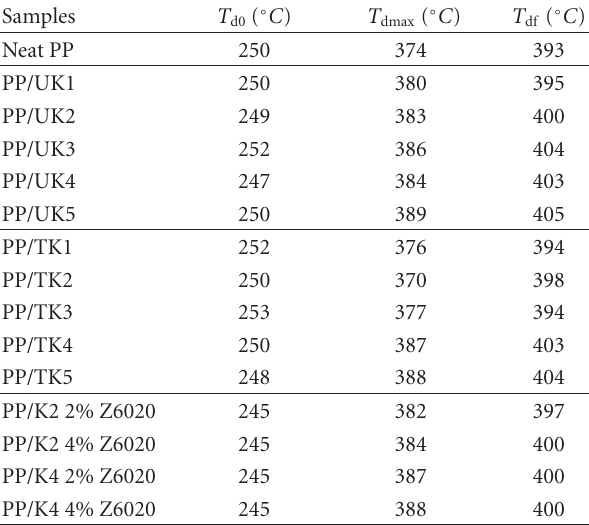
Table 4: PP/kaolin composites degradation characteristics deter- mined from TGA